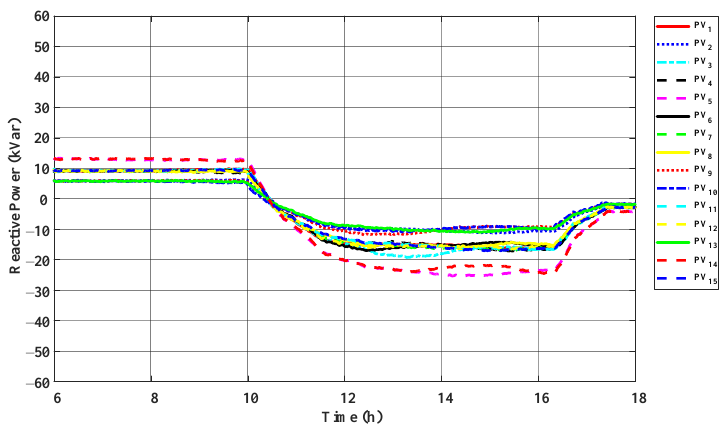
Figure 11. The reactive output of PV with voltage control.